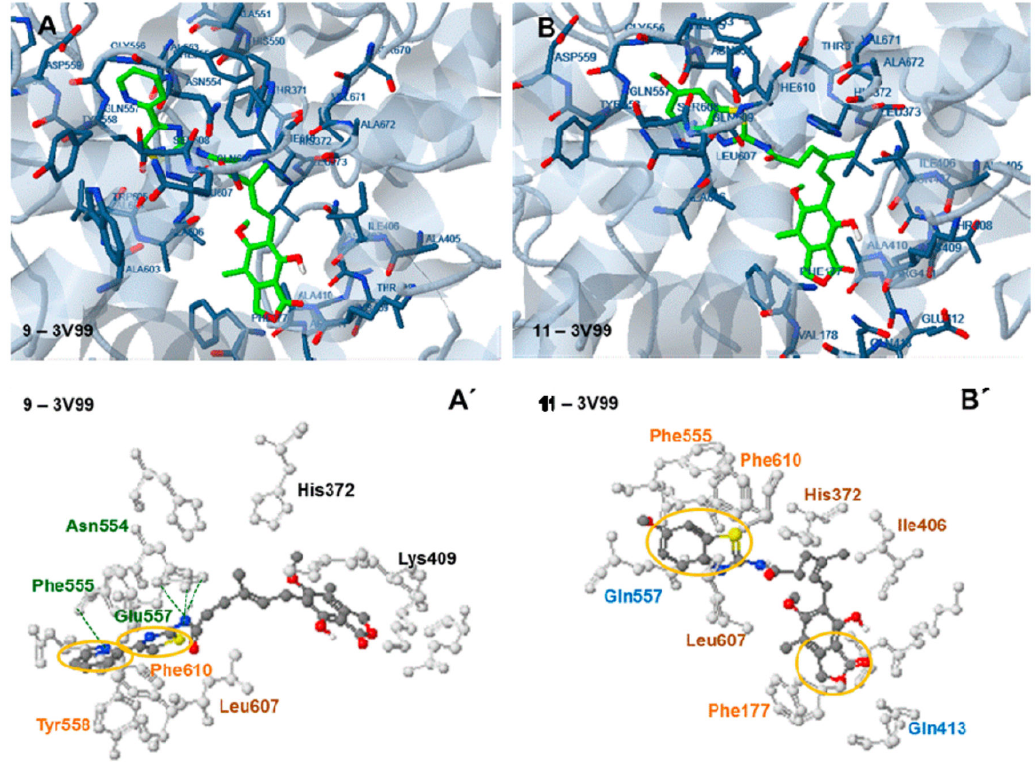
Figure 7. Docking analysis of the most active (IC50 2.5 µ M) compound, 9 , ( A , A (cid:48) ) and the less active, (IC 50 156.25 µ M) compound 11 ( B , B (cid:48) ) with the active site of the human 5-LOX structure PDB ID: 3V99 (target box 30). Green: hydrogen bond interactions, blue: polar interactions, yellow: pi interactions, brown: hydrophobic